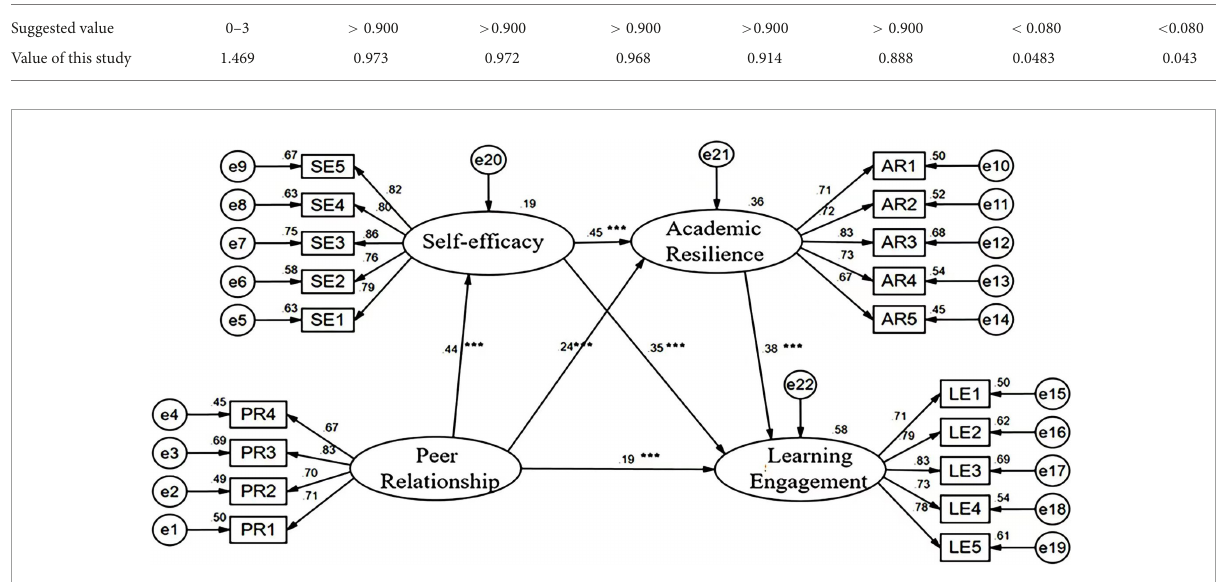
FIGURE2 The structural modeling diagram. *** p < 0.001.